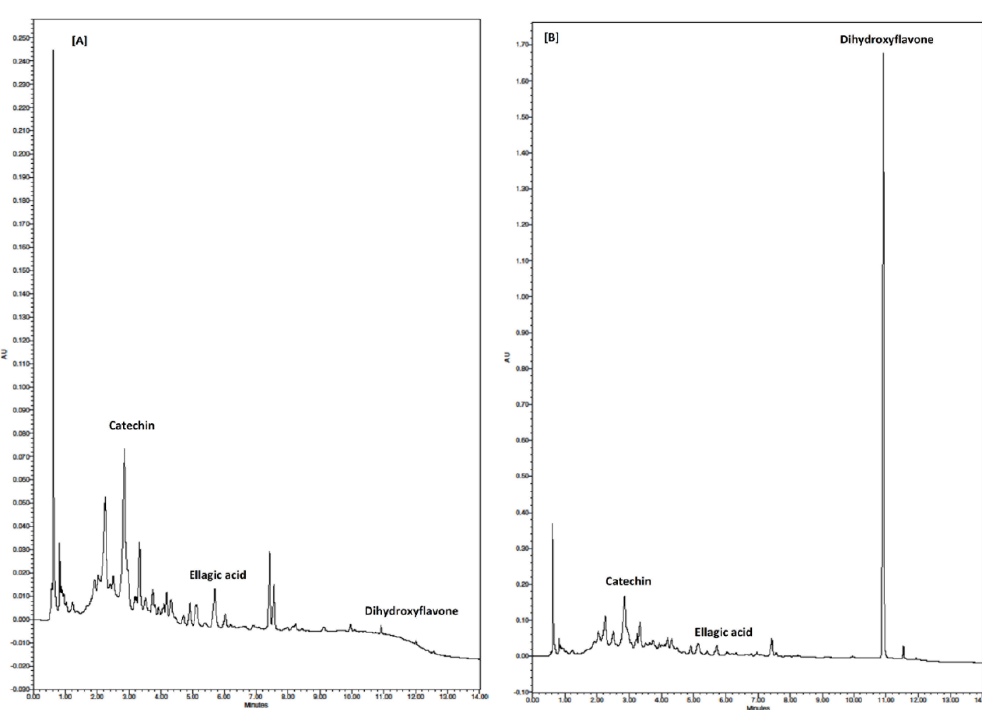
Figure 2. Representative UHPLC-PDA chromatograms of ( A ) feijoa pulp and ( B ) feijoa peel showing the (main) phenolic compounds detected in the respective extracts.